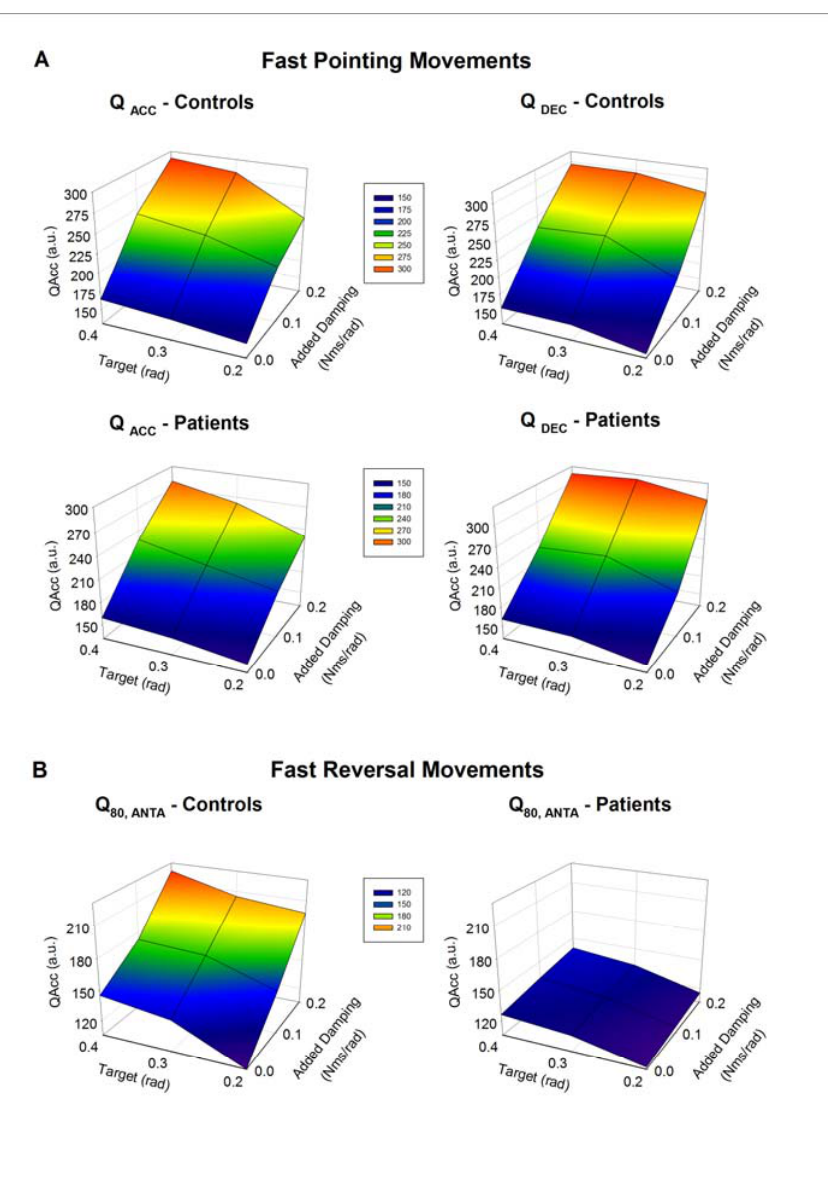
control subjects and in cerebellar patients. B: for fast reversal movements (FRM), control subjects scale appropriately the intensity of the activity of the extensor carpi radialis (ECR) muscle when damping is added and when the aimed amplitude is larger. By contrast, there is a failure of cerebellar patients to adapt the EMG activity as compared to